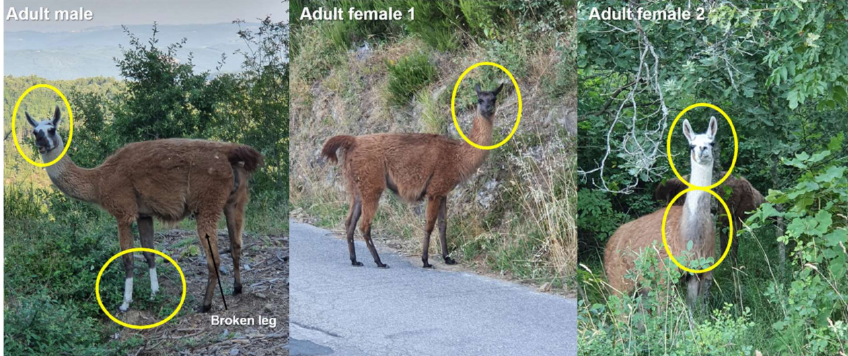
Figure 3. The last three individual llamas observed in January–August 2020 (photo Carlo Gargioni). Circles show individual diagnostic